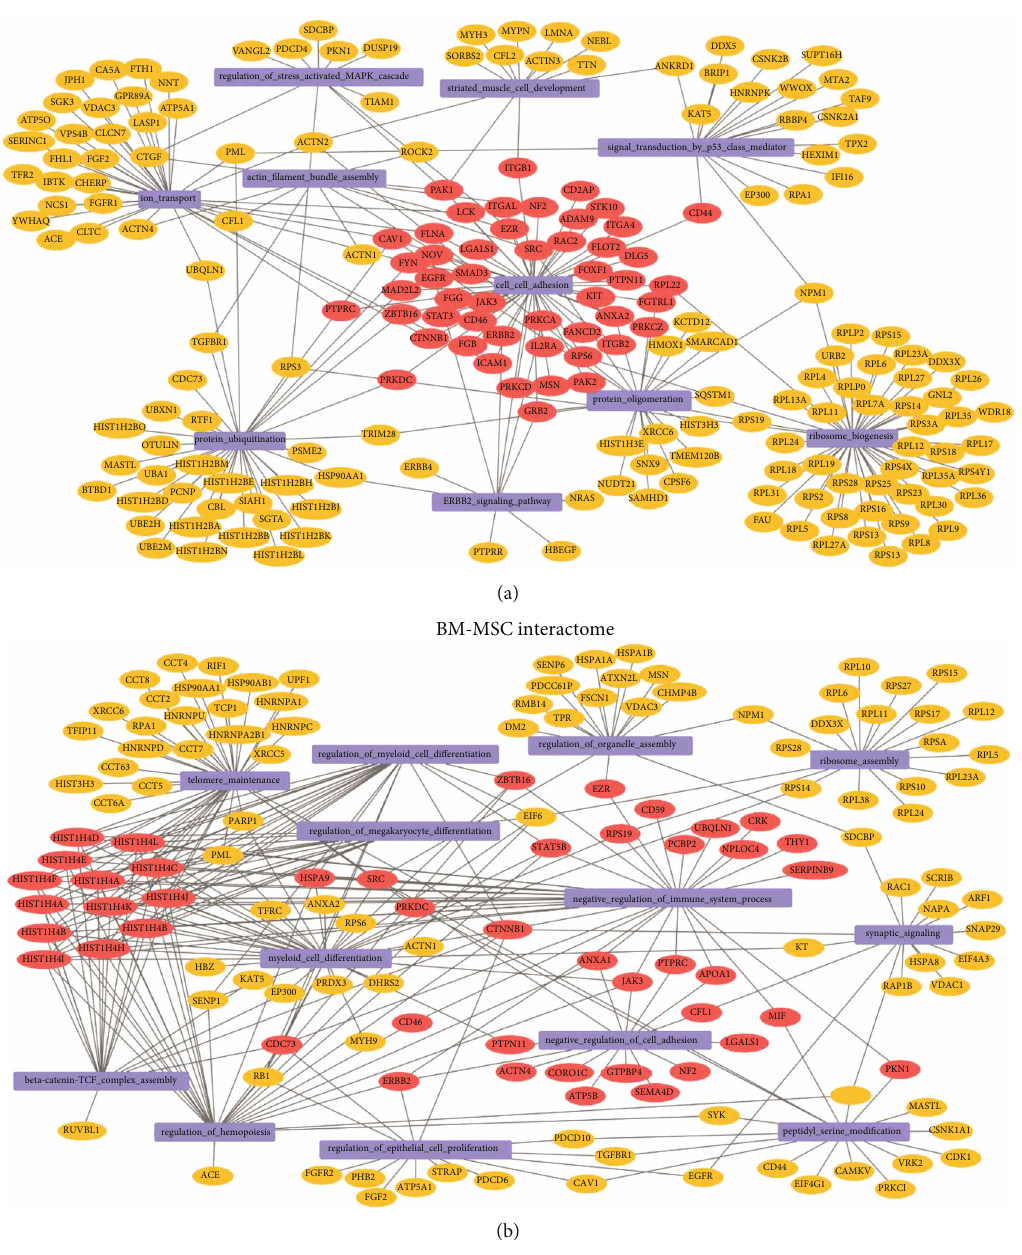
Figure 3: Graphical representation of CPC (a) and BM-MSC (b) interaction networks based on proteomics data